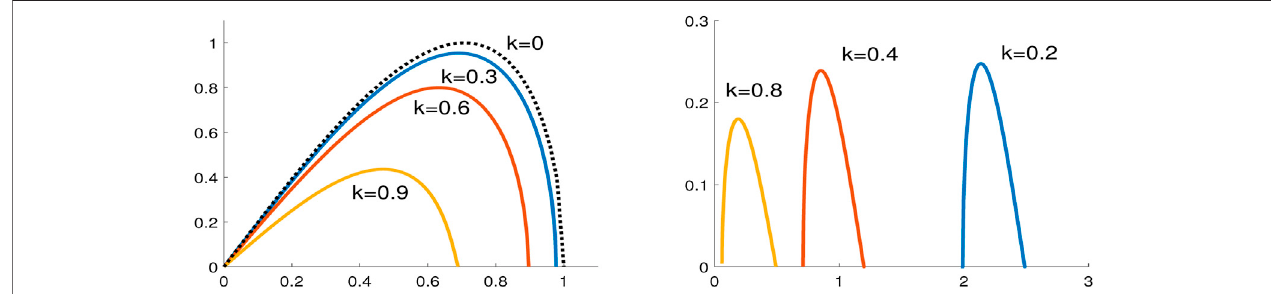
FIGURE 5 | Lax spectrum on the λ -plane (left) and stability spectrum on the Λ -plane (right) for the amplitude-normalized double-periodic wave Eq. 2.15 with k (cid:2) 0 . 85 (top) and k (cid:2) 0 . 95 (bottom) .